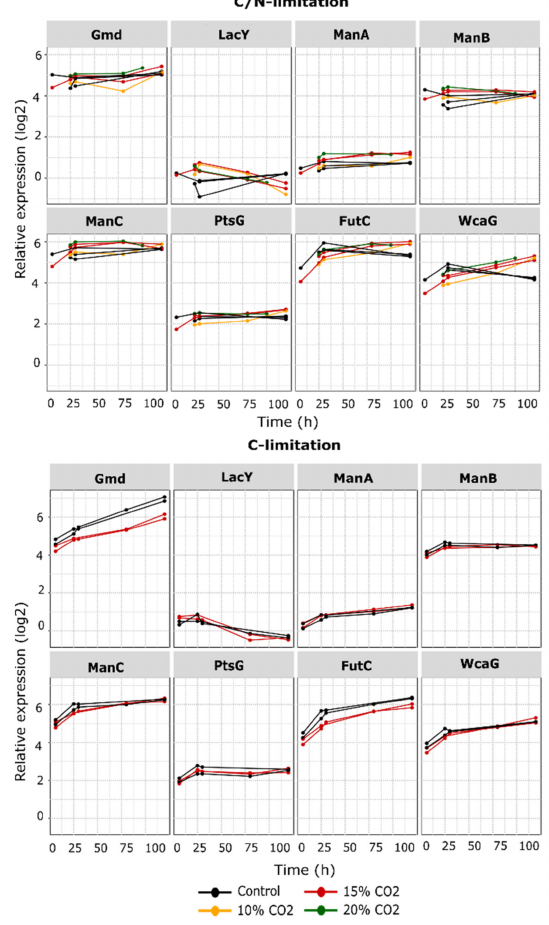
Figure 8. Expression profiles of proteins in the 2 (cid:48) -FL production pathway. Y -axis = relative expres- sion in log2, X -axis = fermentation age after feed start (h). Gmd: GDP-mannose